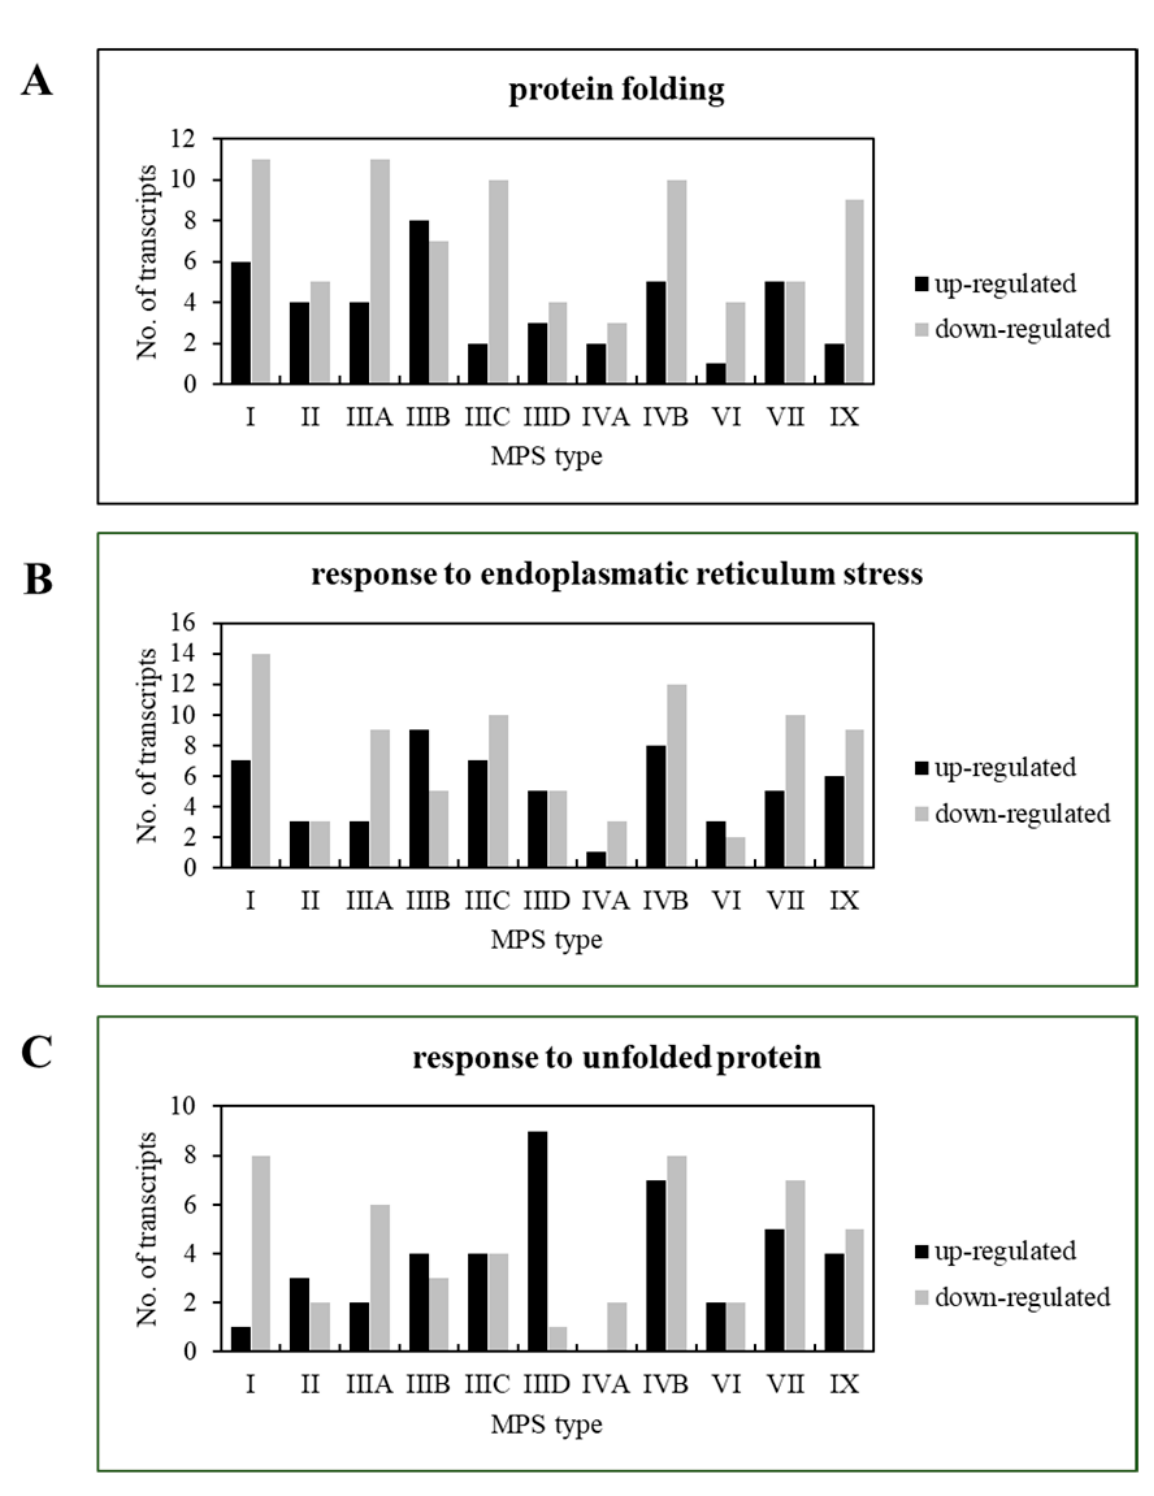
Figure 5. Changes in expression of genes coding for proteins involved in protein folding ( A ), response to endoplasmic reticulum stress ( B ), and response to unfolded protein ( C ) in MPS cells. Transcriptomic analyses indicating up- and down-regulation of genes represented in indicated Gene Ontology pathways (terms) in tested MPS fibroblasts relative to HDFa control cells. The number of genes of each class with significantly affected expression in MPS cells is shown in every panel.